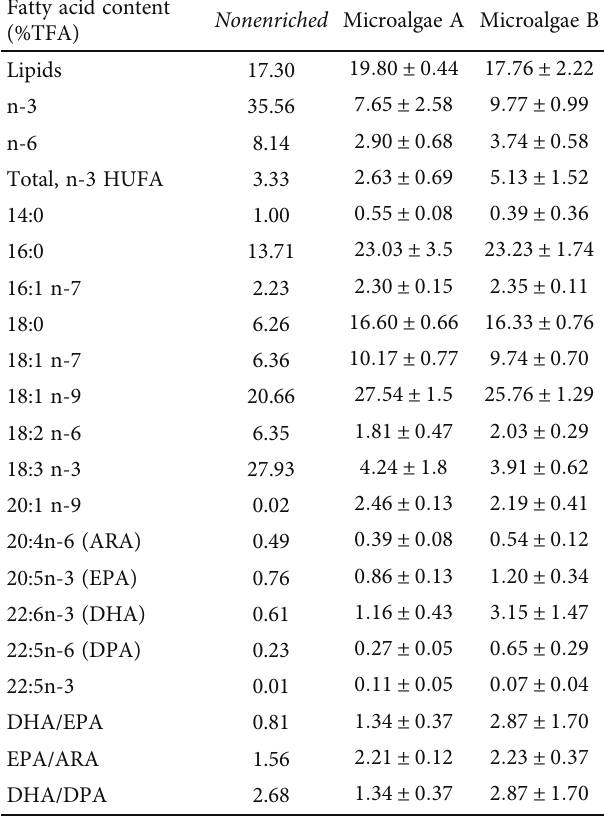
Table 2: Lipid (%dry matter) and fatty acid composition (%TFA) of Artemia Nauplii after 18h enrichment with two experimental emulsions (MA and MB). Fatty acid content data is presented as means ± SD ð n = 3 Þ